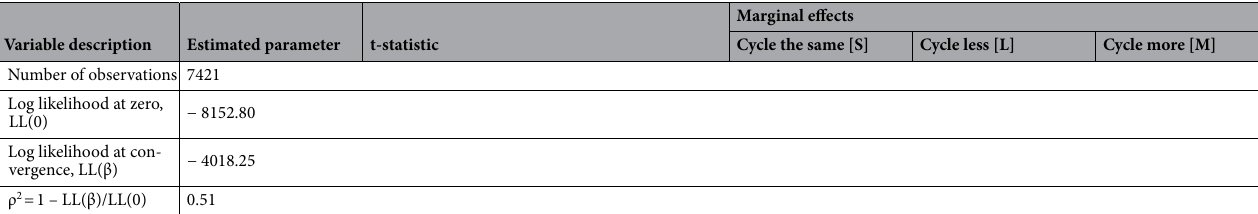
Table 3. Random parameters logit model with heterogeneity in the mean of random parameter on intention to cycle the same amount [S], less [L] or more [M] when COVID-19 pandemic is no longer a threat. The